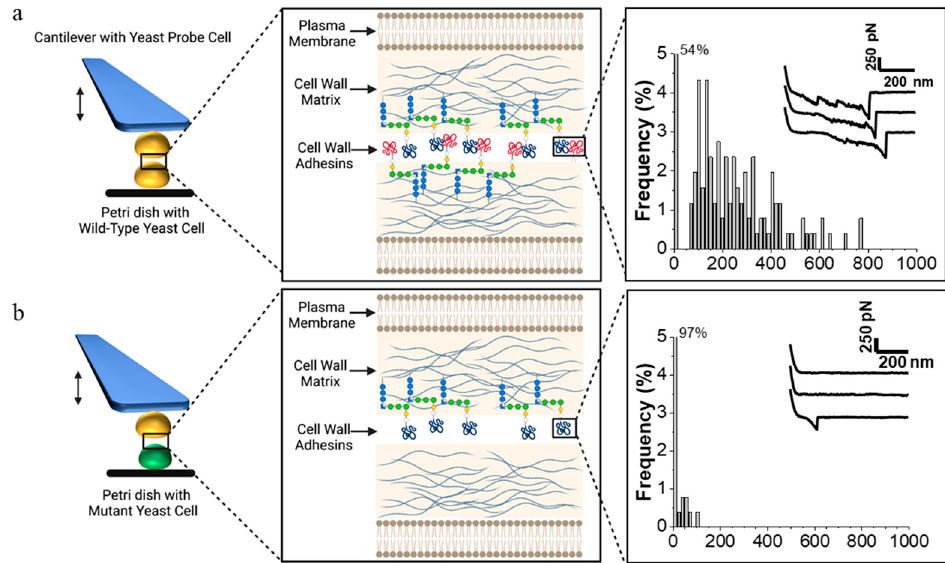
Figure 3. SCFS demonstration of the cellular role of a gene product in cell interaction. FluidFM-based SCFS allows for many different strains to be used as cell probes successively. Each cell probe can be brought into contact with many different cells in a petri dish. ( a , left ) A yeast cell probe attached to the cantilever interacts with a cell in the petri dish on the surface of the microscope stage through multiple cycles of contact and retraction of the probe. In the case of a mating experiment, the two cells are of opposite mating types. ( middle ) Details of cell surface showing cell membrane and cell wall, including blue glucan fibers and adhesins covalently crosslinked to the glucan through modified C-terminal GPI-anchors. ( right ) Histogram of rupture forces on successive adhesion events as the cells are brought into contact, and then separated; the inset shows force–distance curves for three representative contacts. ( b ) The situation when the cell on the microscope stage is a mutant cell, in this case, lacking a cell surface adhesin. This phenotype would result from mutation in the adhesin gene, in a gene required for cellular localization of the adhesin, or in a gene that regulates expression of these genes. In this case, the experiment yields infrequent cell–cell adhesions; thus, 97% of the F–D curves show no force needed for separation. The F–D plots are intended as illustrations only and are reprinted from Dehullu et al. [11].